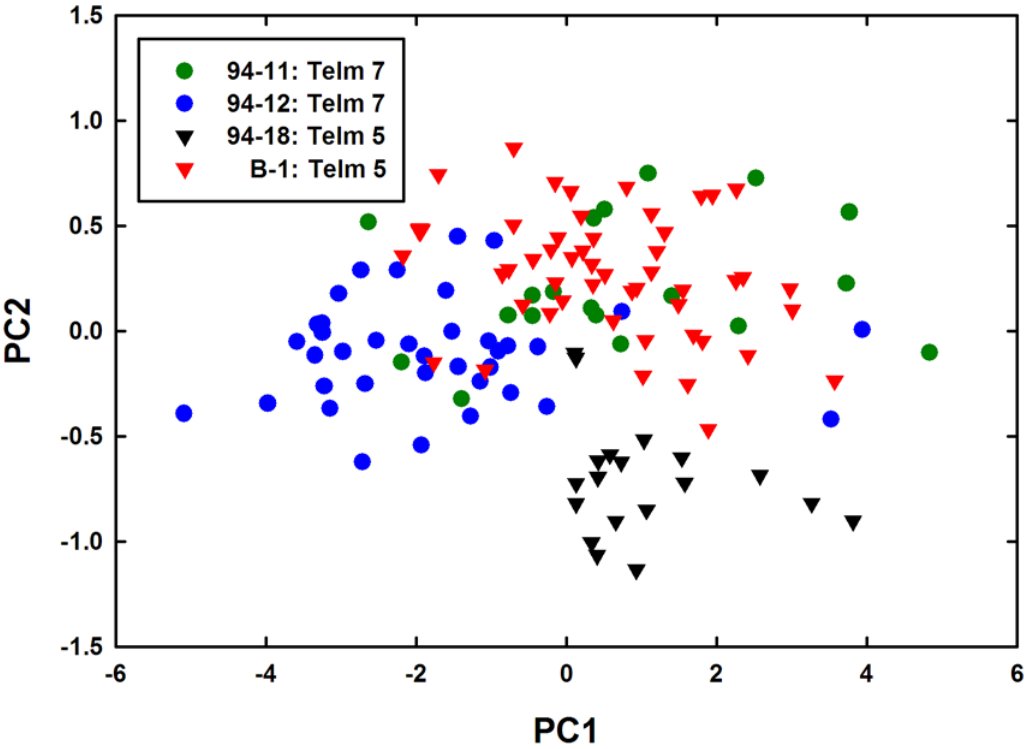
Figure 2. Morphometric analysis of Bouchardiaantarctica shells from before and after the 41-Ma cooling event. Shell-morphology scores for the first two principal components explain 97.7% of the among-site variability. PC1 describes variability in size and PC2 represents variability in shape. Sites B-1 and 94-18 predate the cooling event, whereas sites 94-11 and 94-12 postdate the event.